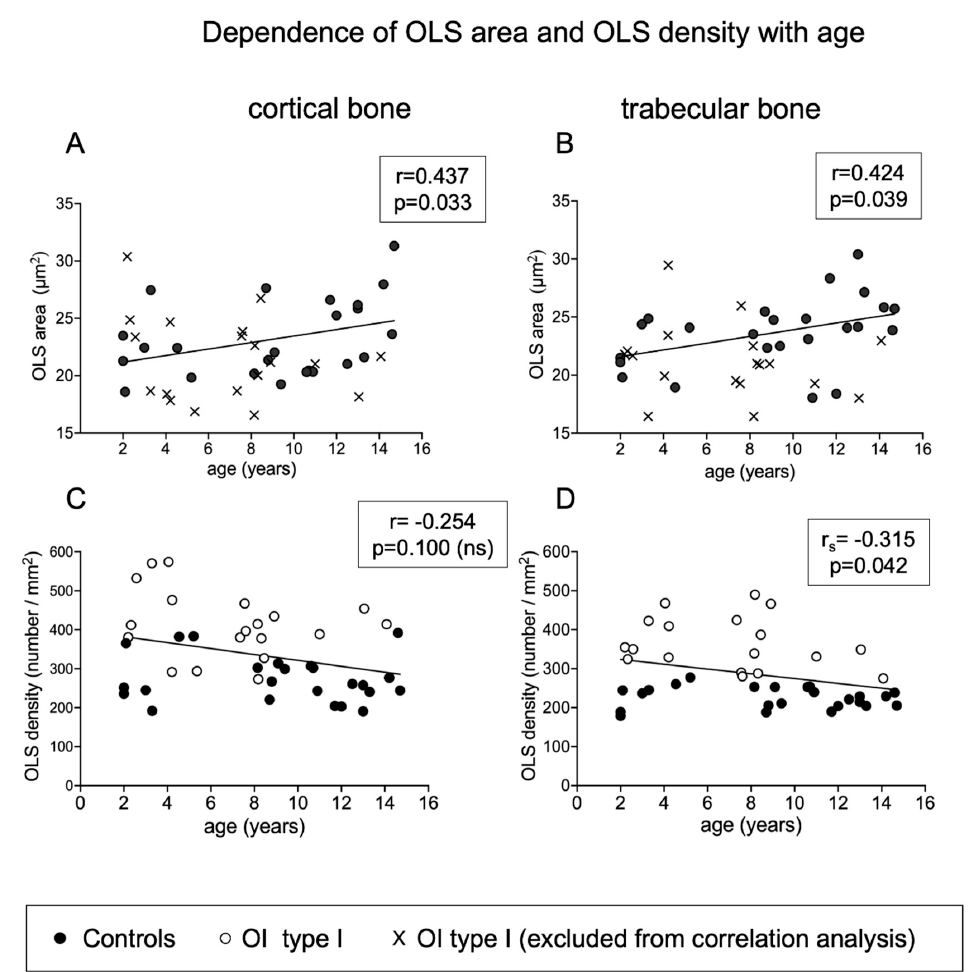
Figure 4. Dependency of OLS area ( A , B ) and OLS density ( C , D ) with age. OLS area increases slightly with age in controls but not in OI type I bone ( p = 0.308 and 0.463, respectively, for cortical and trabecular bone). In contrast, OLS density is negatively correlated with age (total sample analysis). Note that at all ages, OLS density is higher in OI type I (white circles) than in controls (black circles).